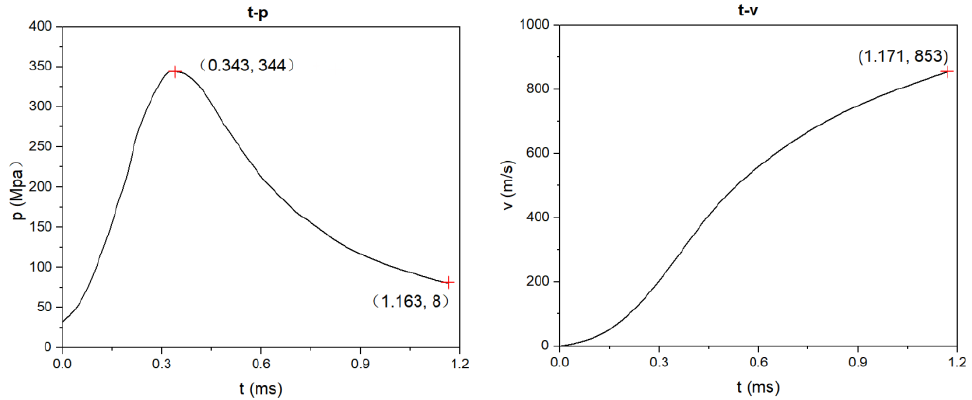
Figure 3. Gatling ballistic curve. When the 7.62 × 51 mm NATO cartridge moves in the barrel, under the joint action of gunpowder gas and rifling, the projectile moves linearly along the barrel axis on the one hand and rotates on the other hand. At this time, there is a certain force on the bullet and barrel. From Equations (5)–(8), the rifling guide side will give the bullet a driving edge force N and give the barrel’s lateral force and axis force. As shown in Figures 4 and 5, the OZ axis is parallel to the barrel axis, and the Z axis direction is the bullet movement direction. N is driving edge force N, fN is friction force. The lateral force on the barrel is F 1 and the axial force is F 2